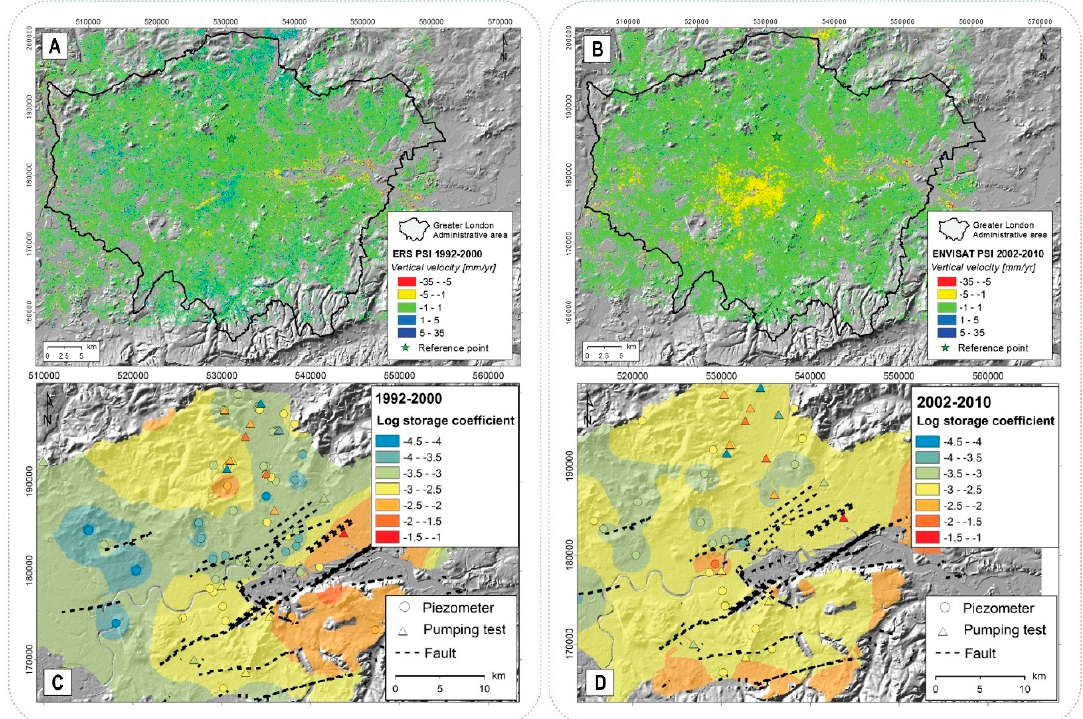
Figure 12. Vertical ground surface velocities estimated for the London Basin with PSI analysis based on ERS and ENVISAT SAR data in ( A ) 1992–2000 and ( B ) 2002–2010; maps of the aquifer storage coefficient in ( C ) 1992–2000 and ( D ) 2002–2010 determined with the use of 1-D aquifer compaction model proposed by Hofmann et. al. [83]; modified after [23].